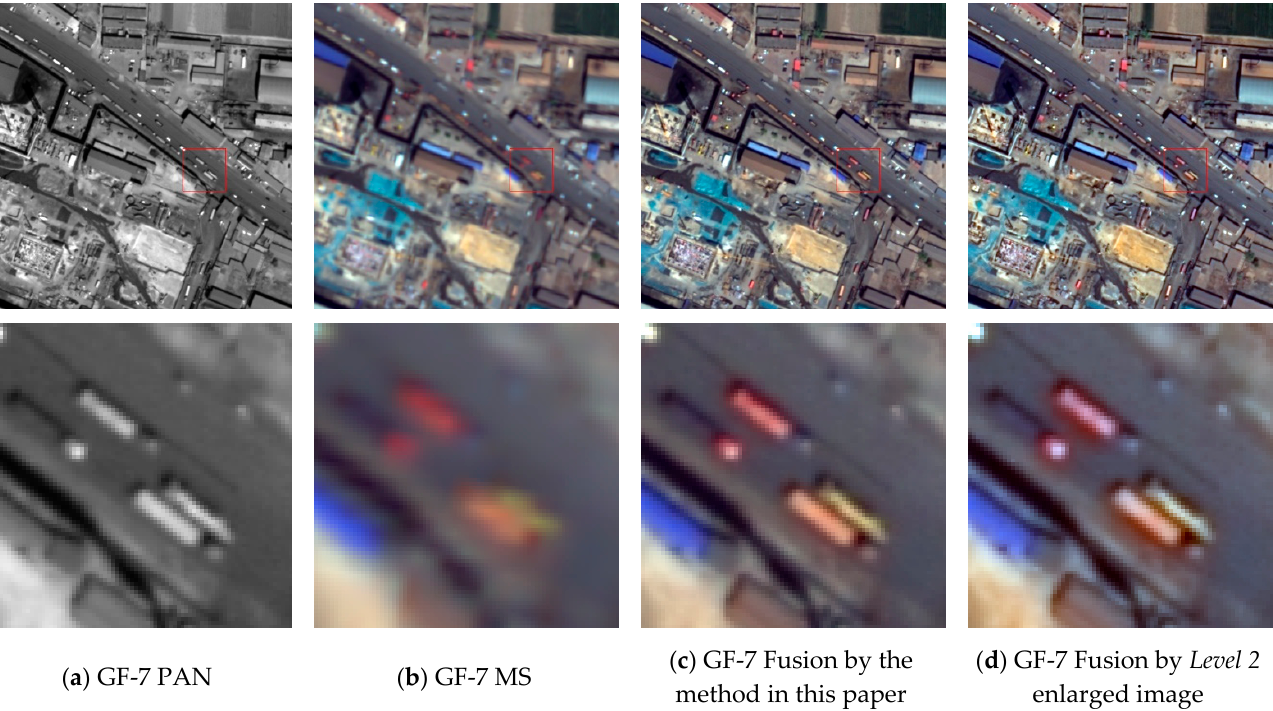
Figure 7. Comparison of the GF-7 fusion image created using the method in this paper and the fusion image created using the Level 2 PAN and MS enlarged image. ( a ) PAN image; ( b ) enlarged MS image; ( c ) fusion image created using the method in this paper; ( d ) fusion image created using the enlarged Level 2 image.